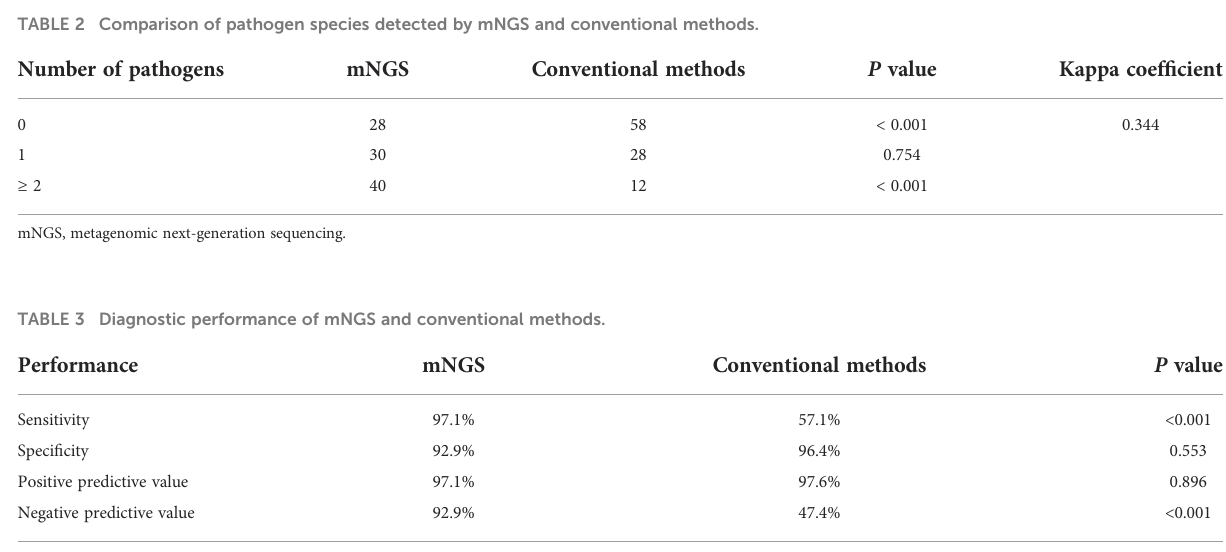
TABLE 2 Comparison of pathogen species detected by mNGS and conventional methods. Number of pathogens